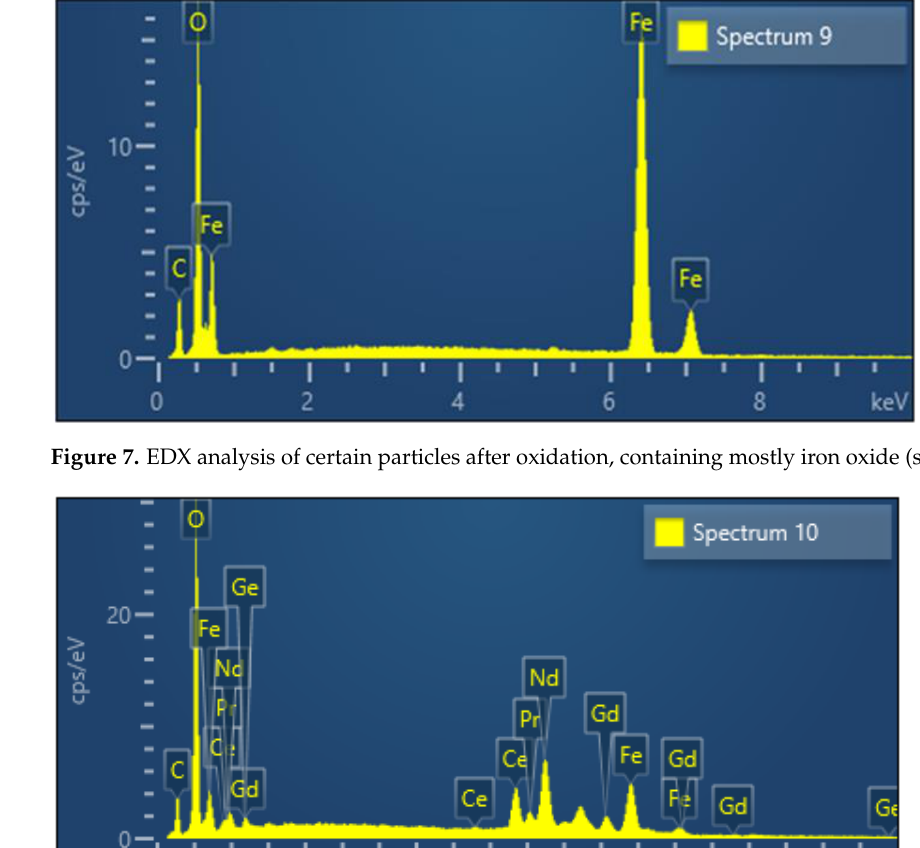
Figure 8. EDX analysis of the particles after oxidation (spectrum 10)